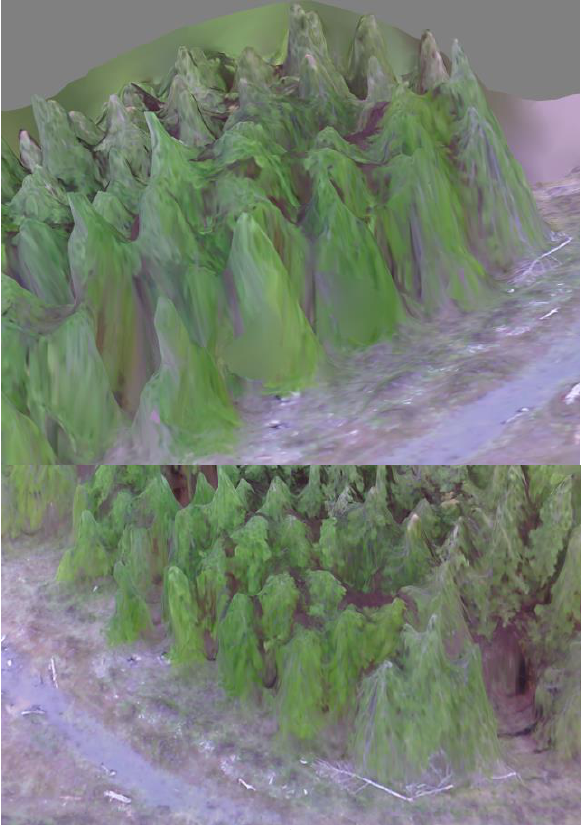
Figure 5: 3D reconstruction of trees observed using VIS with SfM obtained using software by